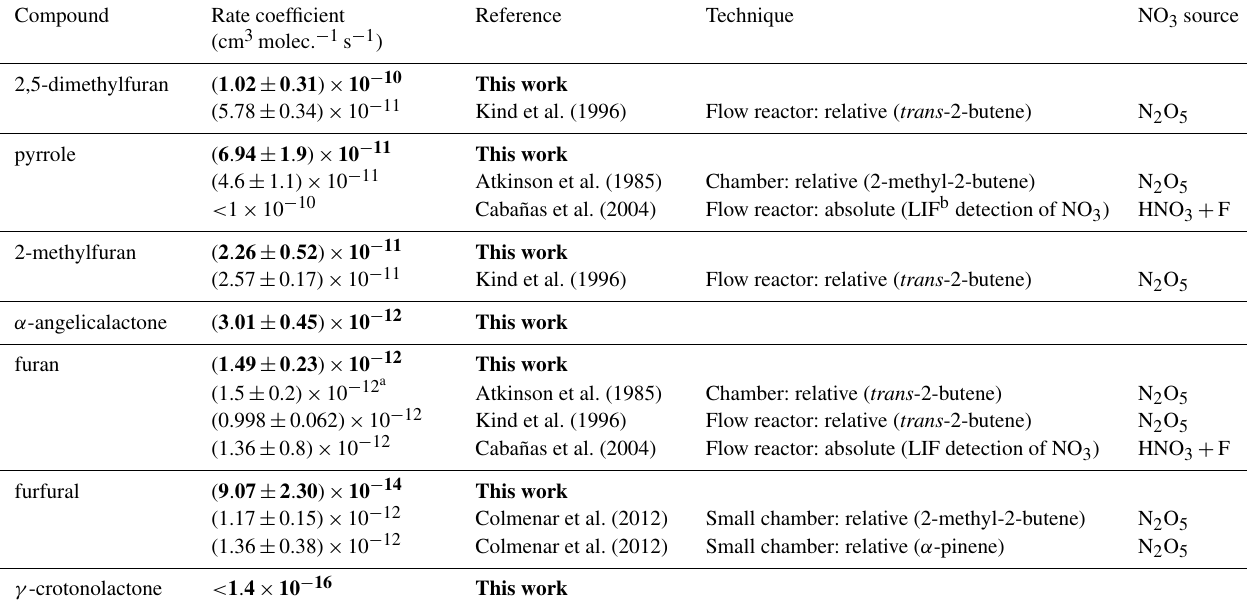
Table 4. Recommended NO 3 rate coefficients from this work compared to those reported in the literature. Recommended values from this work (Table 3) are given in bold.